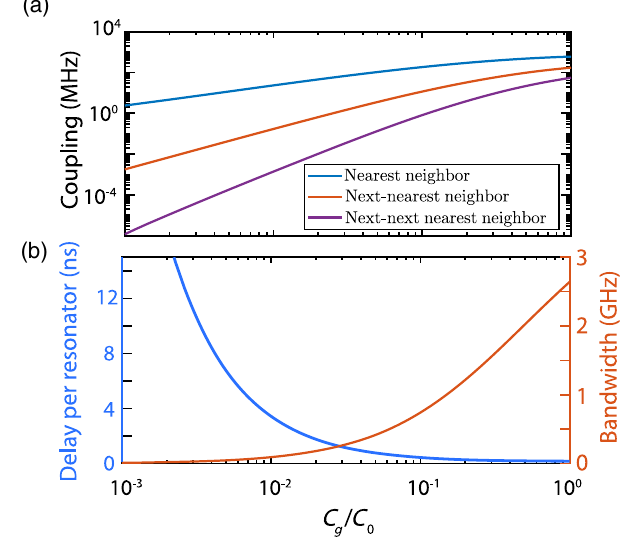
FIG. 6. (a) Magnitude of nearest-neighbor, next-nearest-neigh- bor, and next-next-nearest-neighbor interresonator couplings in an (infinite) capacitively coupled resonator array as a function of =C 0 ratio. The bare resonator frequency is chosen to be the C g 4.8 GHz. (b) Magnitude of delay per resonator and bandwidth of =C 0 ratio. The bare resonator the passband as a function of the C g frequency is again chosen to be 4.8 GHz, and the calculated delays are for frequencies in the middle of the